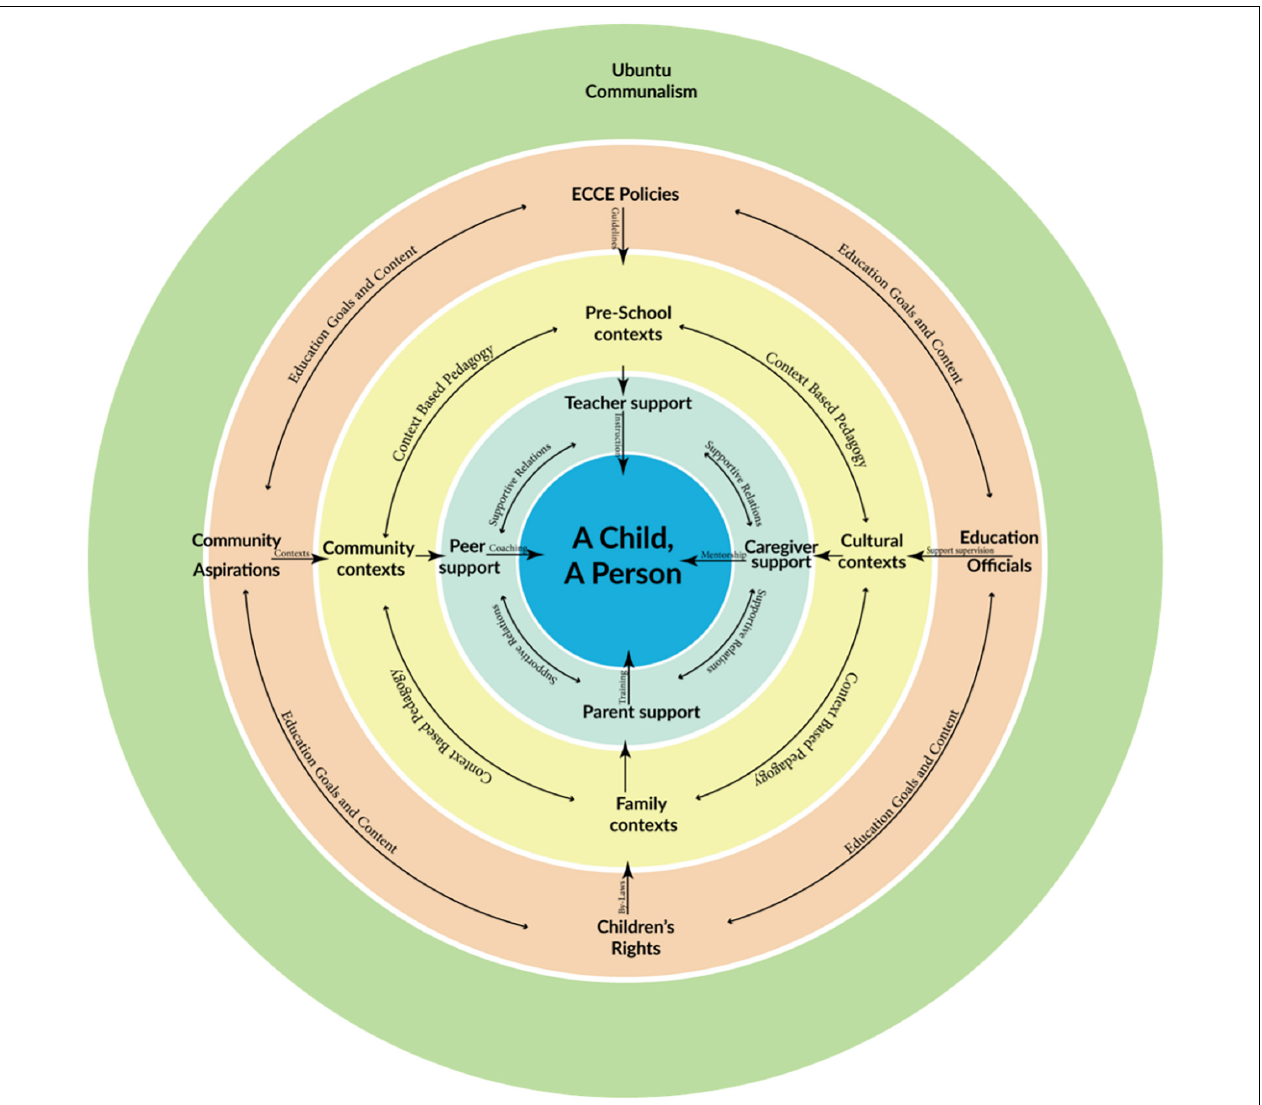
FIGURE 1 | The Africentric inclusive home-based early childhood education model adopted and adapted from the European Agency for Special Needs and Inclusive Education (2016).